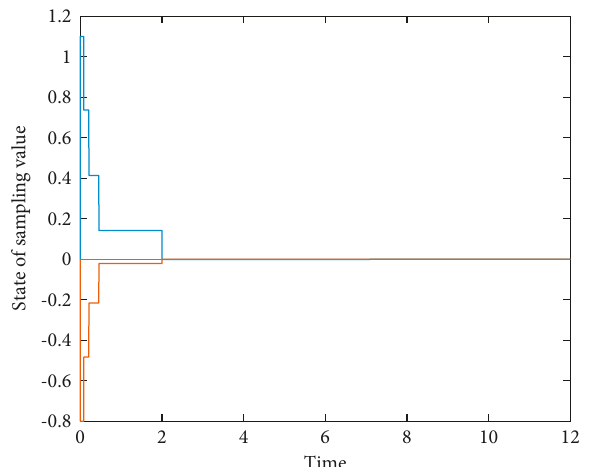
Figure 8: The state of sampling value is given when α